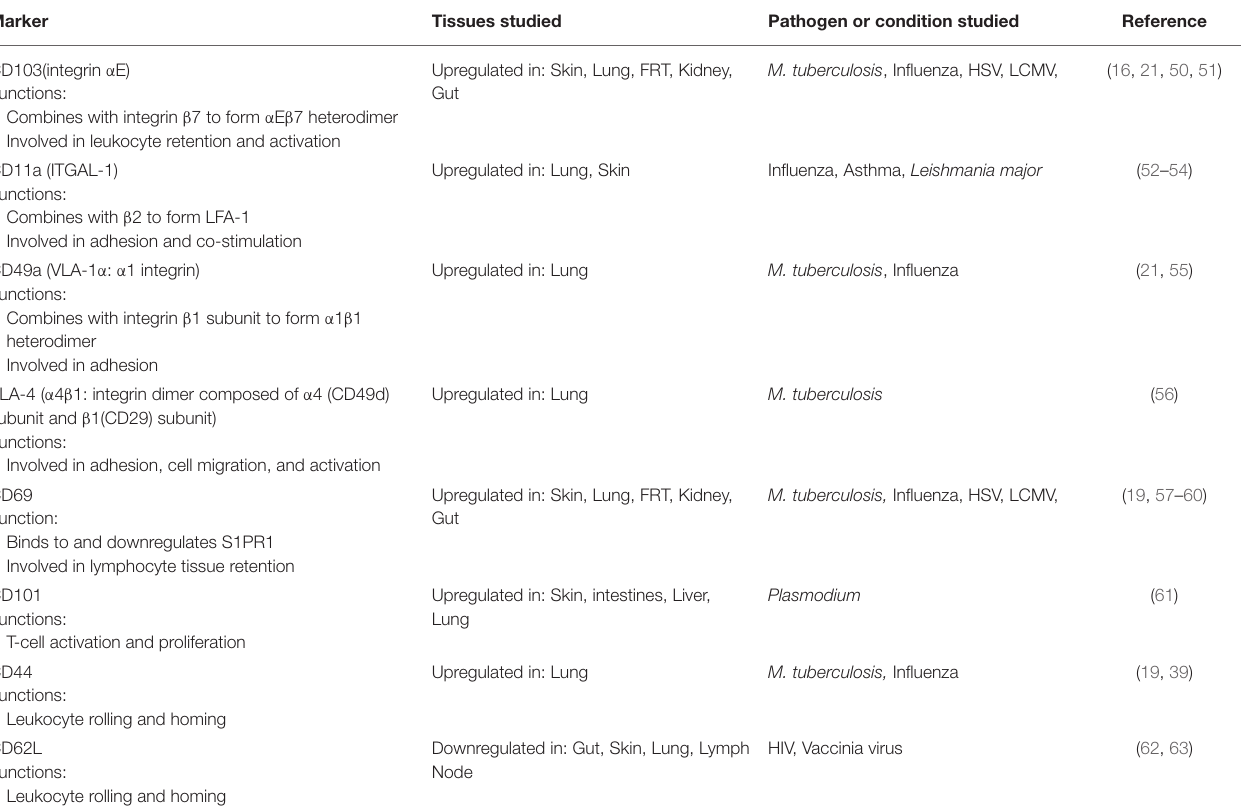
TABLE 1 | Cell surface markers of lung Trms in humans validated in animal models. Marker Tissues studied Pathogen or condition studied